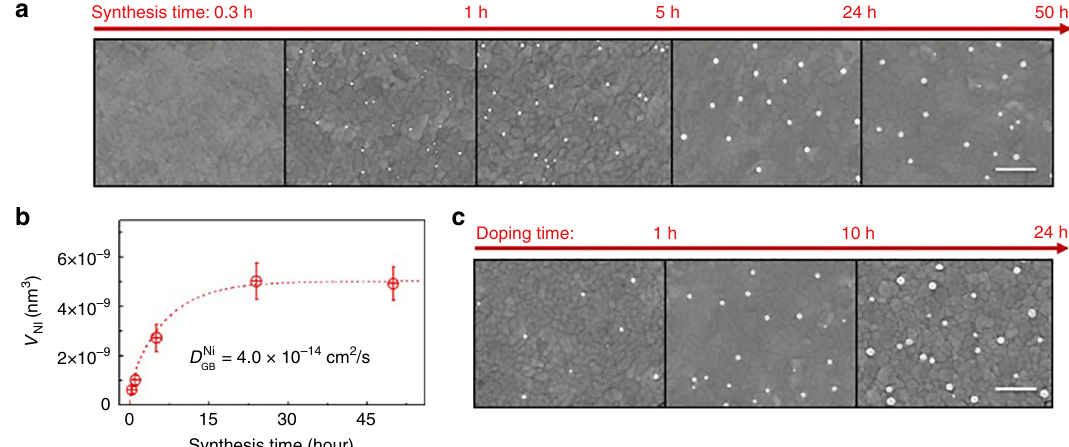
Fig. 4 Evolution of ex-solved nanoparticles. The size-distribution ( a ) and total volume changes ( b ) of synthesized Ni nanoparticles on Sm-doped CeO 2 surfaces as functions of synthesis time and heterogeneous doping time ( c ) at 700 °C (scale bars = 300 nm)